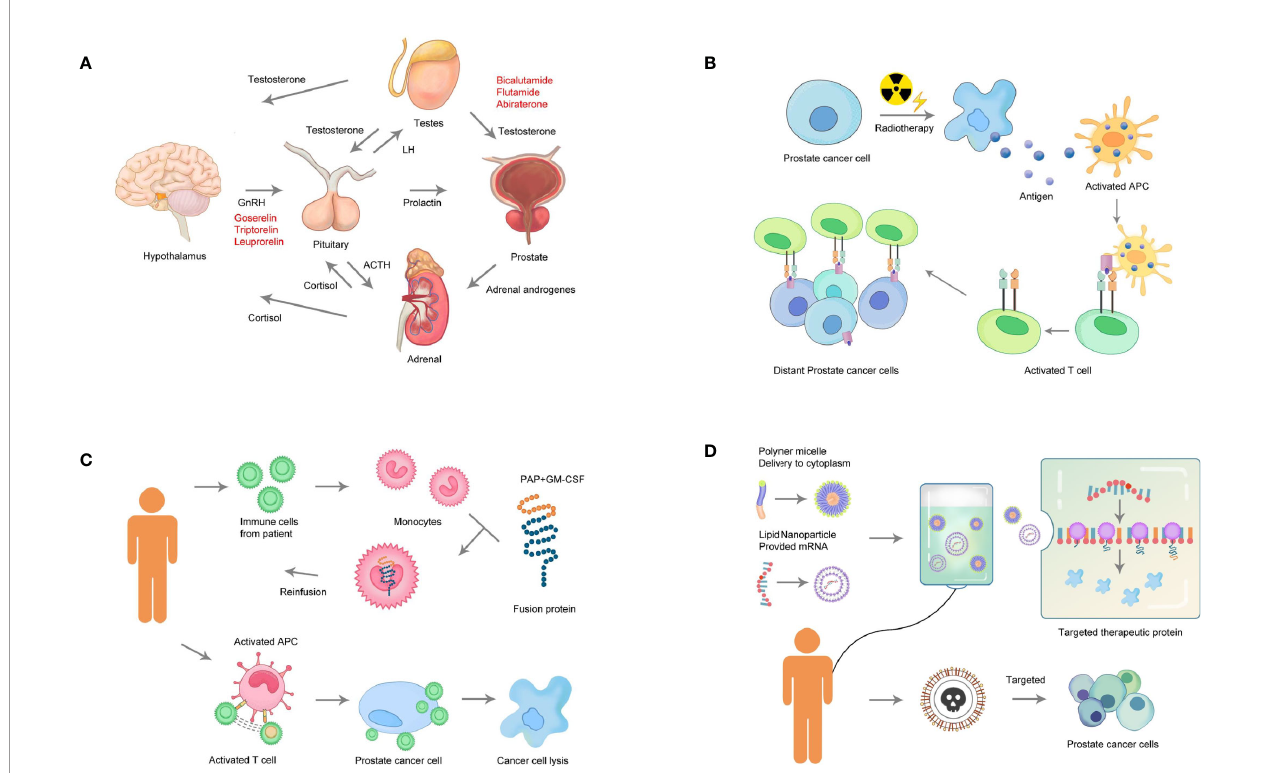
FIGURE 4 | Categories of therapeutic strategies for prostate cancer. (A) Endocrine therapy: Androgens stimulate the growth of PC. Drugs to suppress androgen biosynthesis as therapy for PC (androgen depletion) target adrenocorticotropic hormone (ACTH), gonadotropin-releasing hormone (GnRH), and luteinizing hormone (LH). (B) Radiotherapy: Radiotherapy directly targets the tumor cells, which is followed by the release of tumor antigens and the activation of immune responses. (C) Immunotherapy: The cells are obtained from the patient. The cells highly expressing the target gene or matching the tumor antigen are selected for expansion in vitro . Finally, the expanded cells are transplanted back into the patient. (D) Chemotherapy: Effective components of a gene-targeted chemotherapeutic drug include a polymer micelle that delivers cytotoxic chemicals and mRNA. Loading of the therapeutic protein can lead to the release of toxic components from the PC cells, resulting in cell